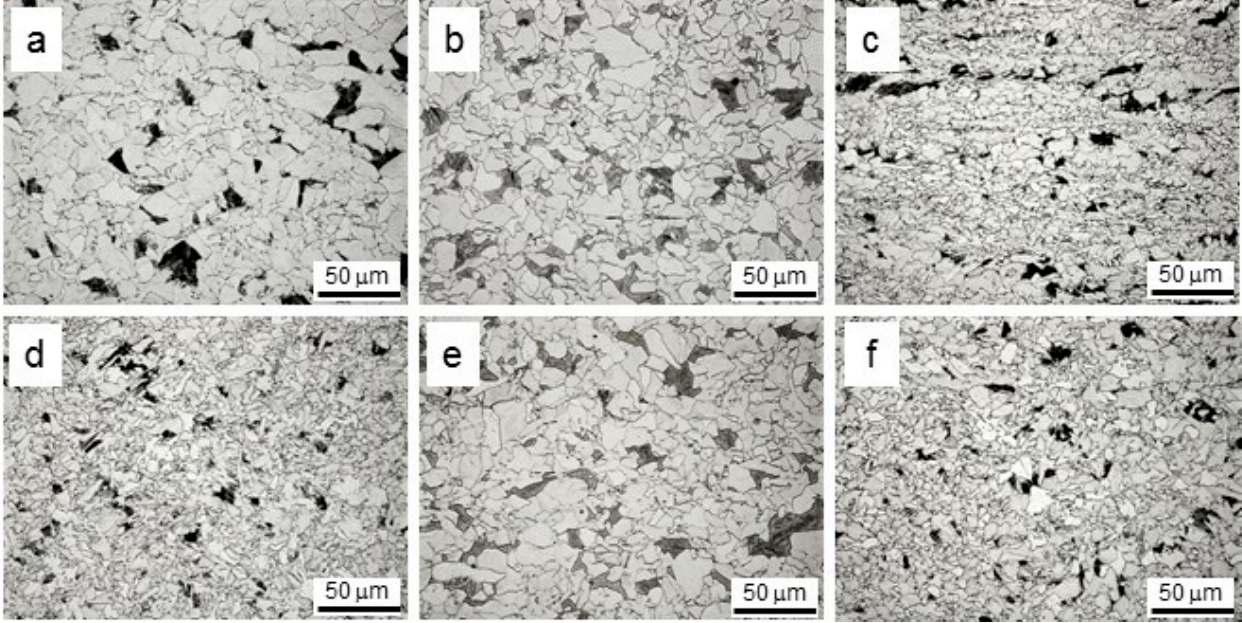
Figure 1. Optical images of microstructures for studied conditions: ( a ) HFT/600/15, ( b ) HFT/650/15, ( c ) LFT/600/15, ( d ) HFT/600/30, ( e ) HFT/650/30, ( f ) LFT/600/30.